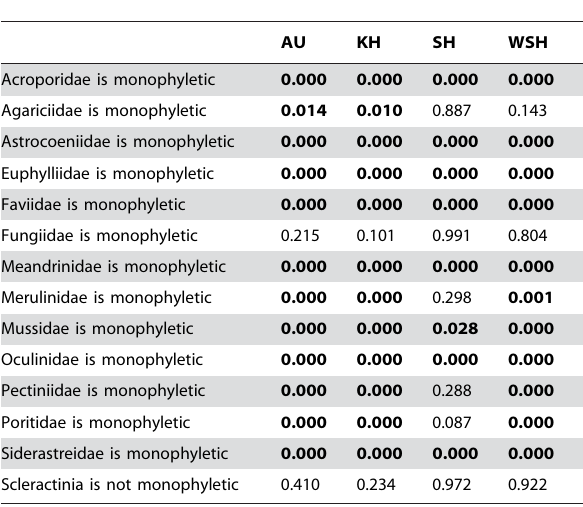
Table 1. Results of hypothesis testing showing p-values for approximately Unbiased (AU), Kishino-Hasegawa (KH), Shimodaira-Hasegawa (SH), and weighted SH (WSH)